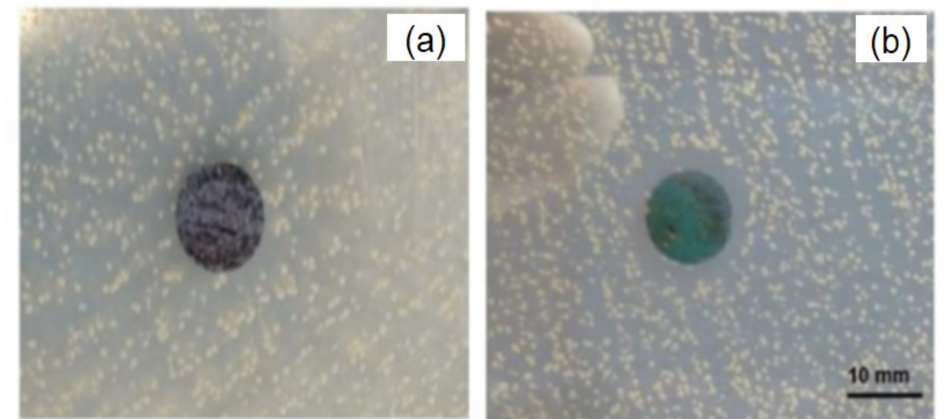
Figure 9. Inhibition experiments: images for 355–500 um after silanization and before Ag NP coating ( a ) and after Ag NP coating ( b ). Ten millimeter scale bar for both images (adapted with permission from reference